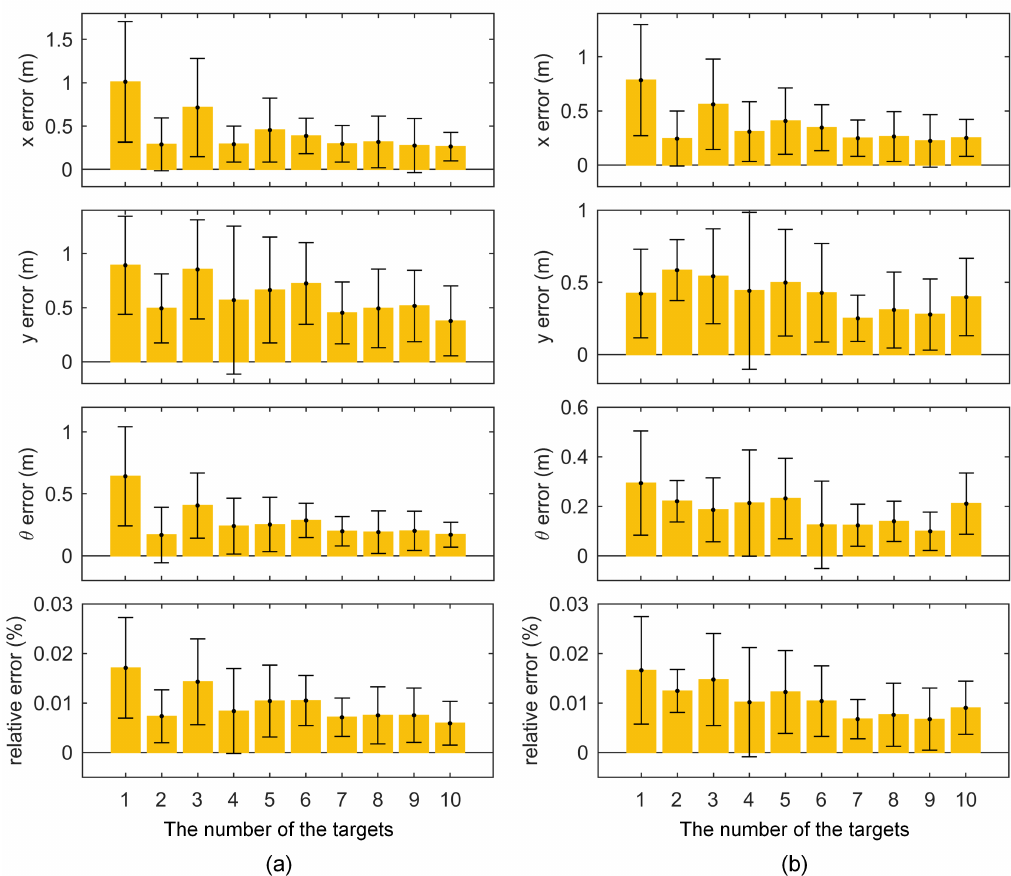
Figure 14. Odometry errors with different number of the targets under trajectories ( a , b ) from Figure 8.